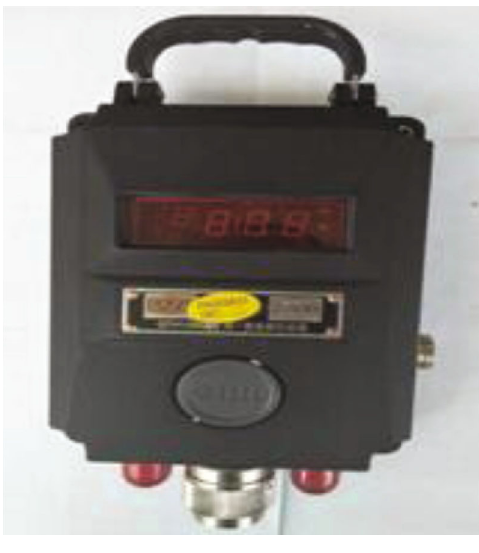
Figure 2: CO volume concentration